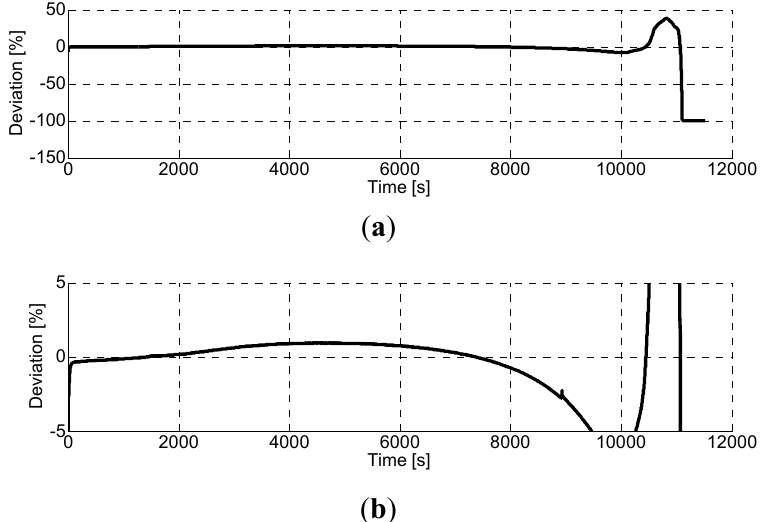
Figure 7. Relative deviation among measured data and model output (proposed procedure). ( a ) Discharge characteristic: Proposed procedure; ( b ) Zoom of Figure